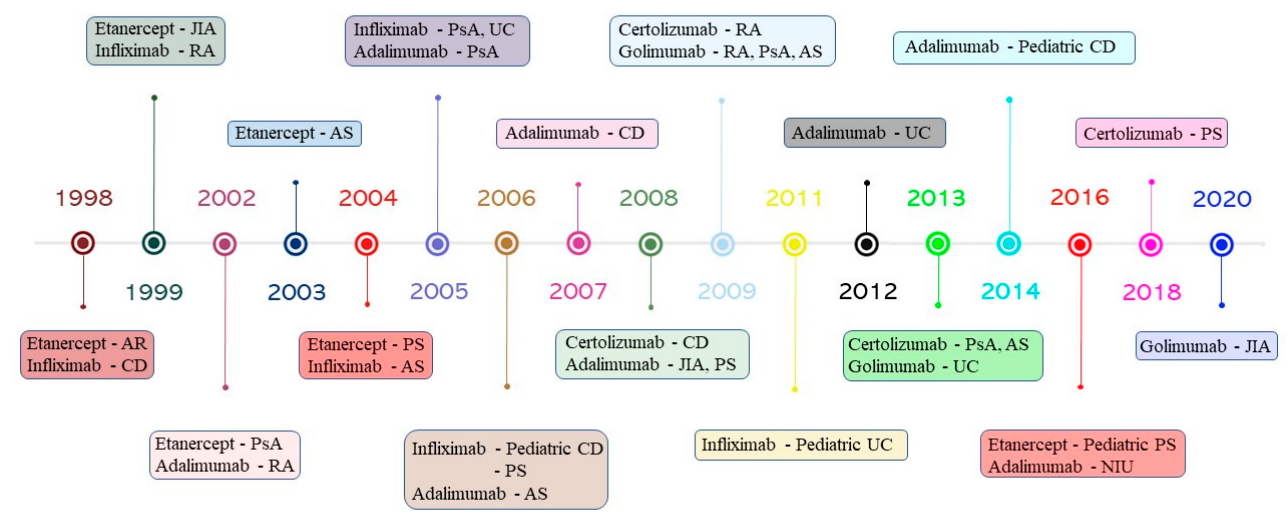
Figure 2. Timeline of the approval of TNF- α blockers in autoimmune diseases. AR, rheumatoid arthritis; CD, Crohn’s disease; AS, ankylosing spondylitis; PsA, psoriatic arthritis; PS, psoriasis; UC, ulcerative colitis; NIU, non-infectious uveitis; JIA, juvenile idiopathic arthritis.